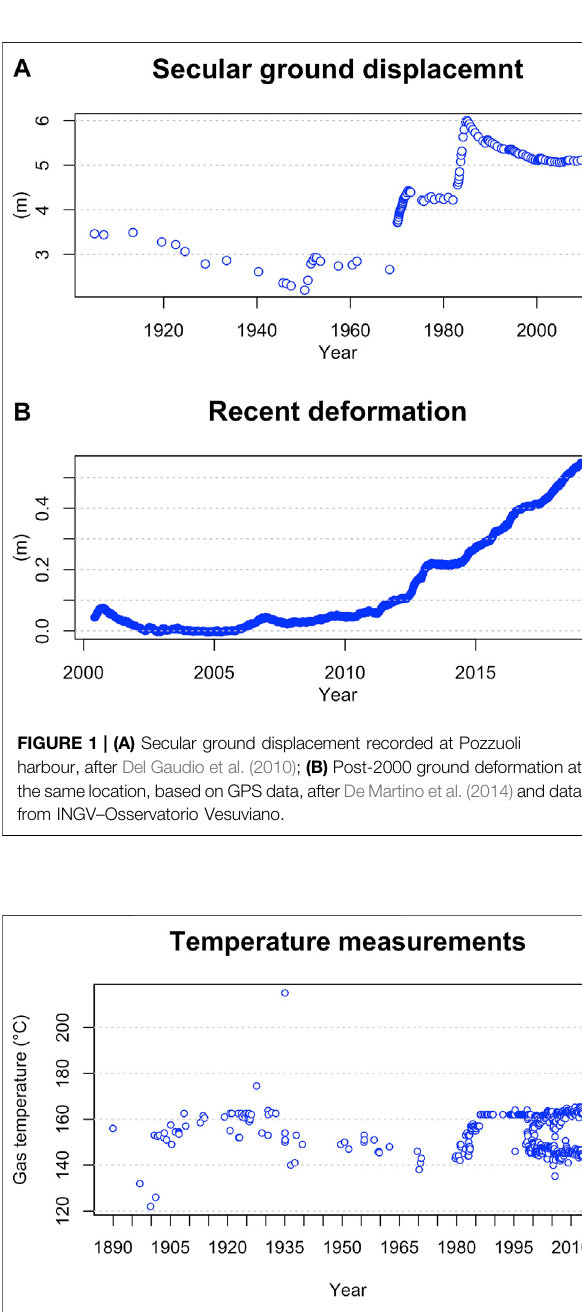
FIGURE 2 | Gas temperature measurements carried out within the Solfatara crater since the end of the 19th century as reported by Sicardi (1941);Sicardi(1970);Dall ’ Aglioetal.(1972);Cionietal.(1984);Martini(1986); Caliro et al. (2014). Data and references for older measurements, described by Sicardi and published in Italian jounals, are provided as Supplementary Materials .